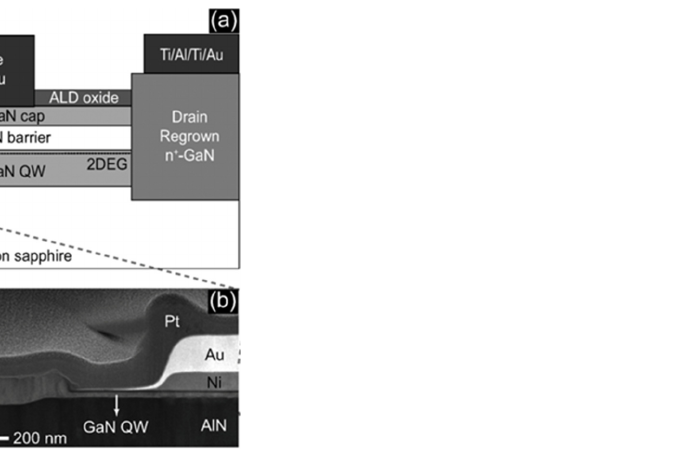
Figure 16. ( a ) The contact resistance of implanted sample pulsed laser annealing shows a low con- tact resistance of 6.84 × 10 − 7 Ω cm 2 . ( b ) The contact resistance under different power densities of pulsed laser annealing [86] . (Data from [86]).